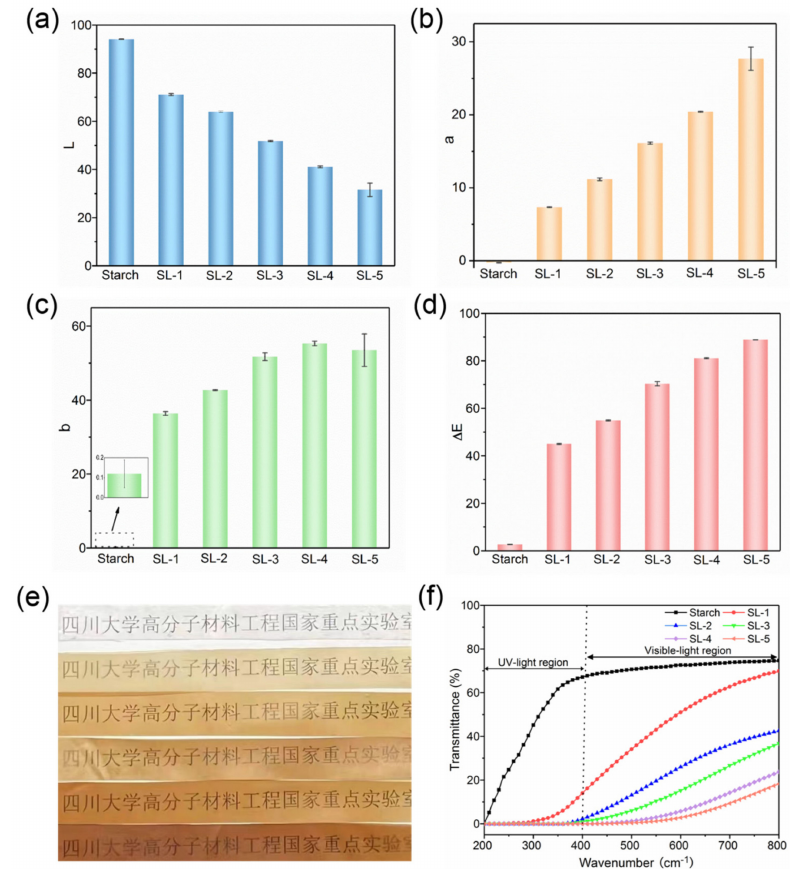
Figure 6. Color index: ( a ) L (lightness), ( b ) a (red/green) value, ( c ) b (yellow/blue) value, and ( d ) (cid:52) E (total color difference), and ( e ) digital photographs (the visibility of the chinese characters (Sichuan University State Key Laboratory of Polymer Materials Engineering) under the films.) and ( f ) UV-vis light transmittance spectra of starch film and SL composite films containing 1% to 5%